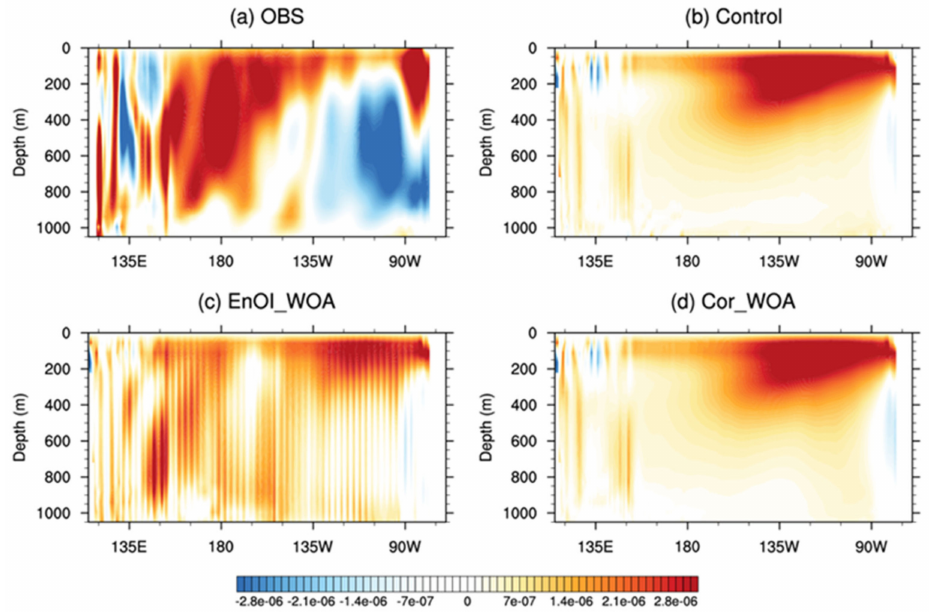
Figure 7. Long-term mean vertical profile of the vertical current in the tropical Pacific (unit, m/s): ( a ) OBS; ( b ) Control; ( c ) EnOI_WOA; ( d )